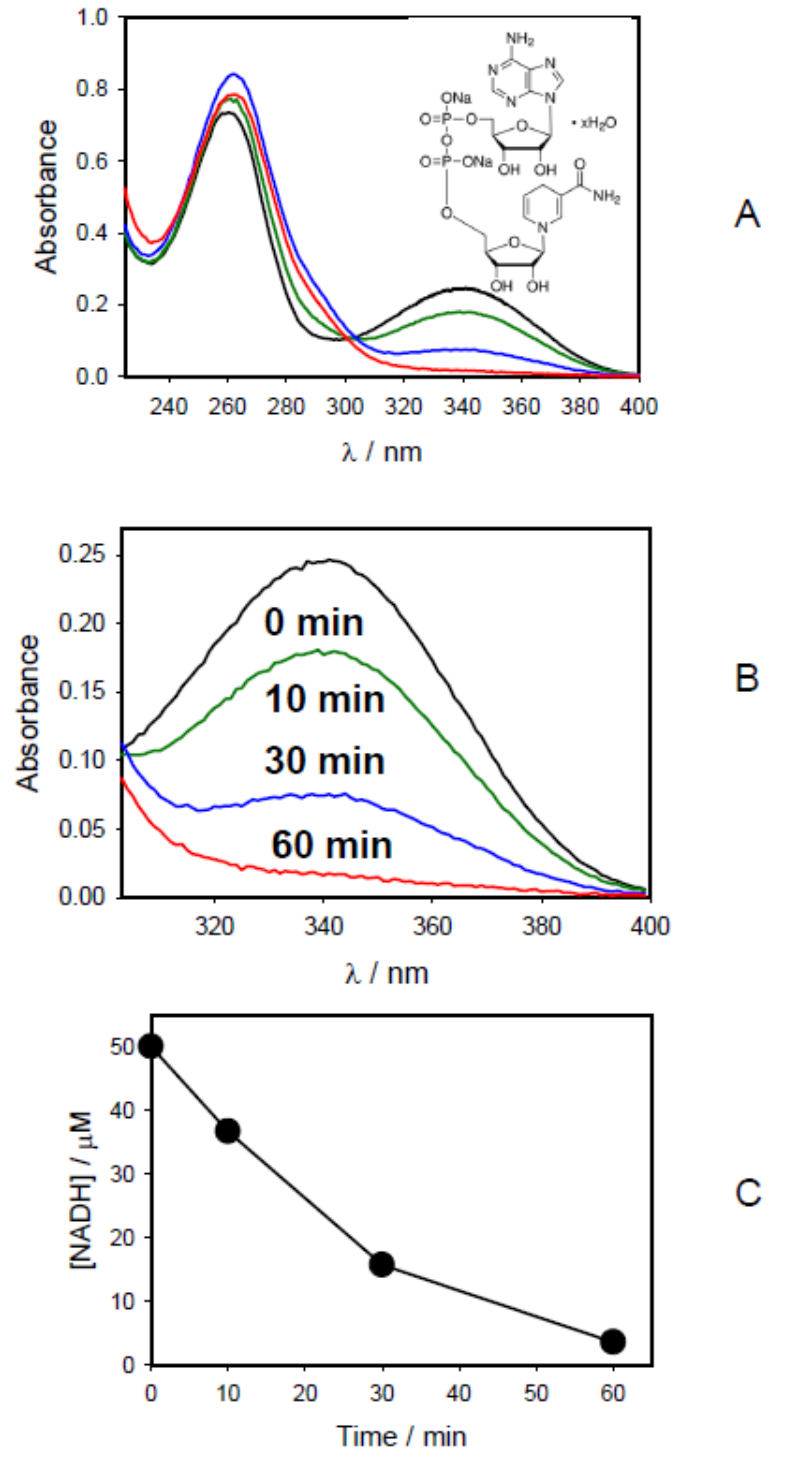
Figure 4. ( A , B ) Absorption spectra of 50 µ M NADH aqueous solution before (1) and after treatment with cold atmospheric pressure He-plasma jet during 10 min (2), 30 min (3), and 60 min (4). ( C ) Dependence of NADH concentration during the time of CAPPJ calculated from the absorption spectra shown in Figure 4B and a calibration curve.